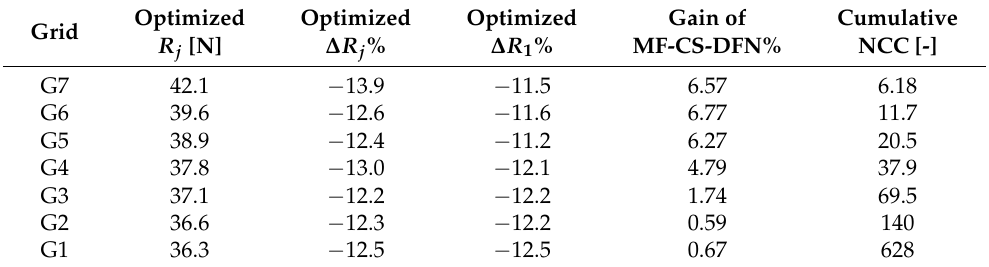
Table 4. MF-CS-DFN (DtSr) resistance and its reduction, G1 validation of the resistance reduction, resistance improvement (gain) with respect to the CS-DFN, and cumulative normalized computational cost for each